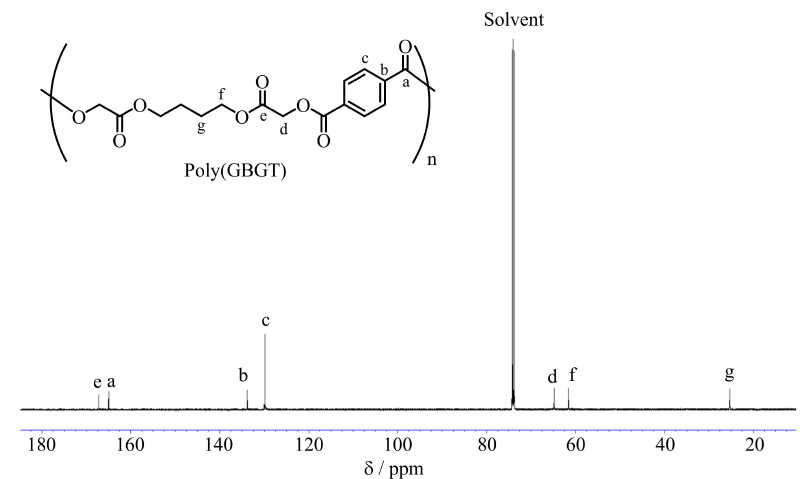
Figure 2. 1 H NMR spectrum of poly(GBGT) (Table 1, Run 1) (C 2 D 2 Cl 4 , 500 MHz, 130 ◦ C). Red color: relative intensity.